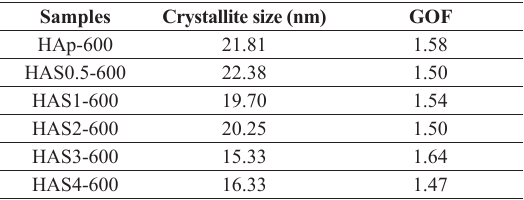
Table 1. Crystallite size and GOF values of the synthesized